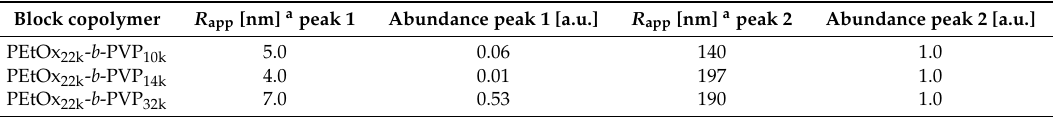
Table 2. Summary of apparent intensity weighted average hydrodynamic radii of PEtOx 22k - b -PVP xxk determined via